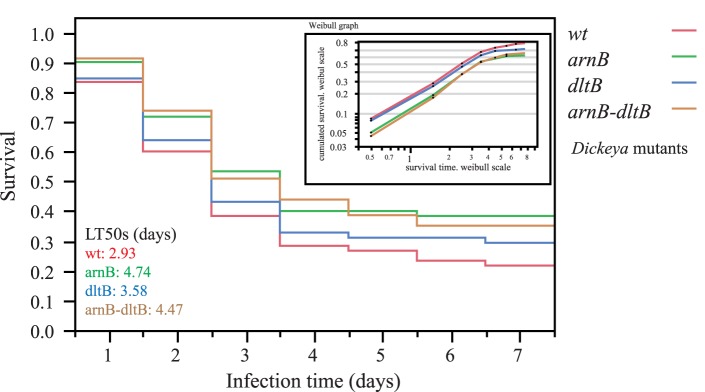
Survival of pea aphids after oral infection by wt and mutants of D. dadantii 3937.Survival is shown for aphids treated with wt bacteria (red), arnB (green), dltB (blue), and dltB arnB (brown) mutants. Results were obtained with 2×30 third instar aphid nymphs per treatment, including a diet-treated control (no mortality, not shown). The experiment was repeated twice with very similar results (p<0.06 in all comparisons of wt with arnB mutants). Median survival times (LT50s) were calculated with a Weibull fit (inlet), and give the following series [95% confidence intervals]: wt, 2.92 [2.18–3.92]; arnB, 4.74 [3.42–6.55]; dltB 3.58 [2.62–4.88] and arnB-dltB double mutant, 4.46 [3.23–6.18].